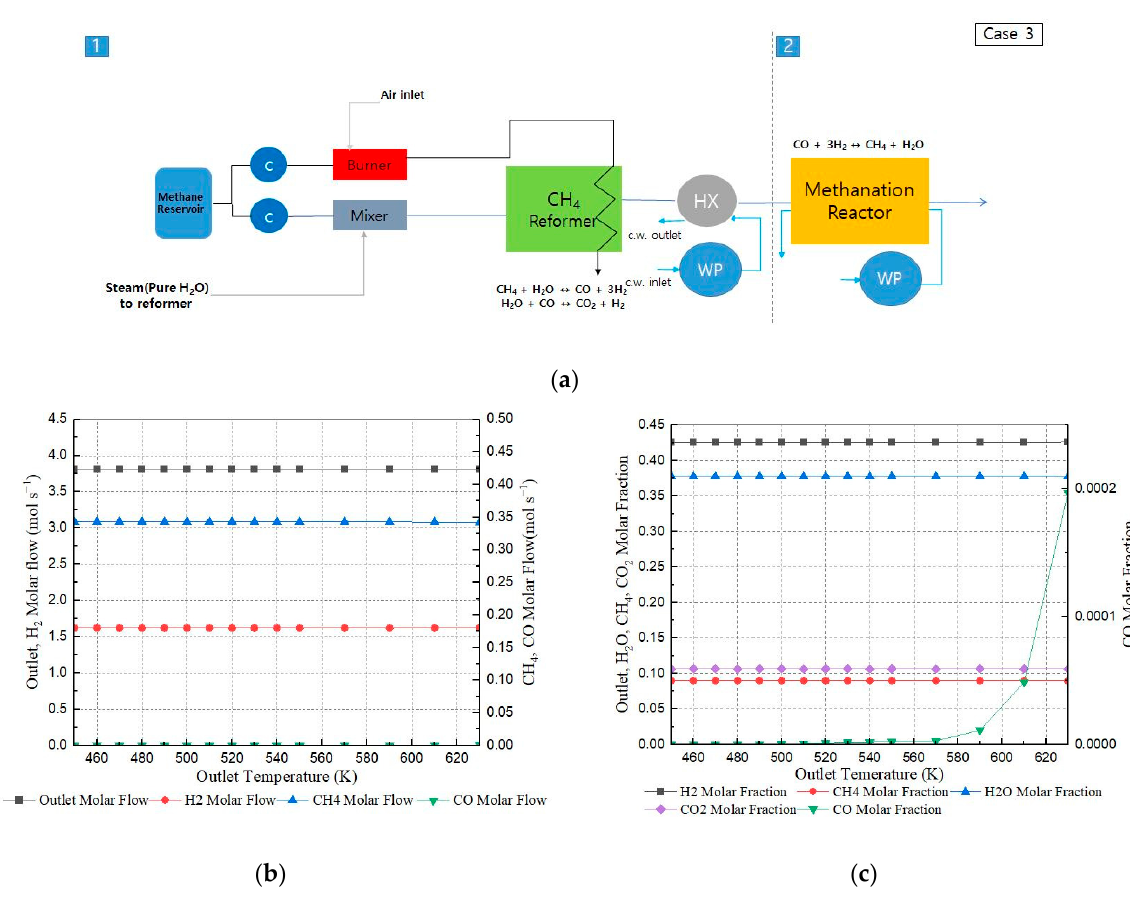
Figure 6. Schematic of ( a ) Case 3 reforming system and Graph of ( b ) molar flow and ( c ) molar fraction of outlet side .